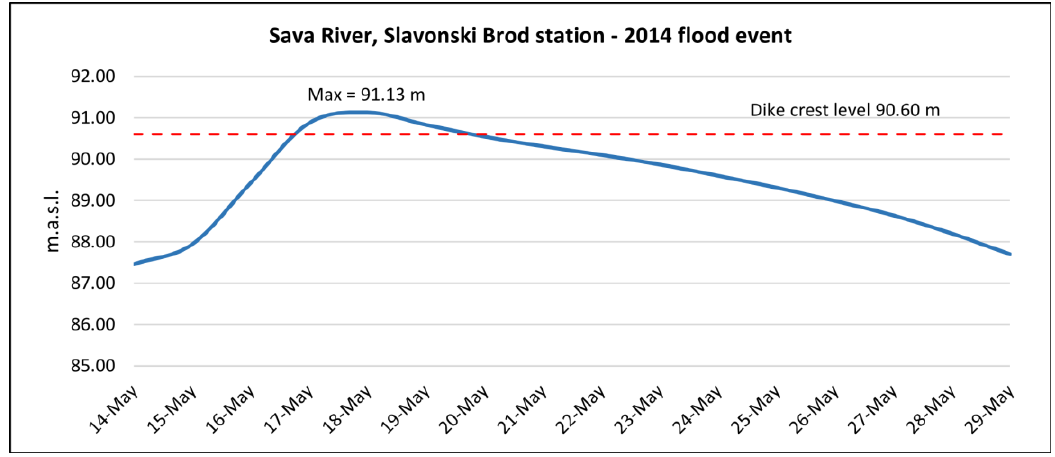
Figure 2. Stage data measured at gauging station Slavonski Brod during the 2014 flood event.